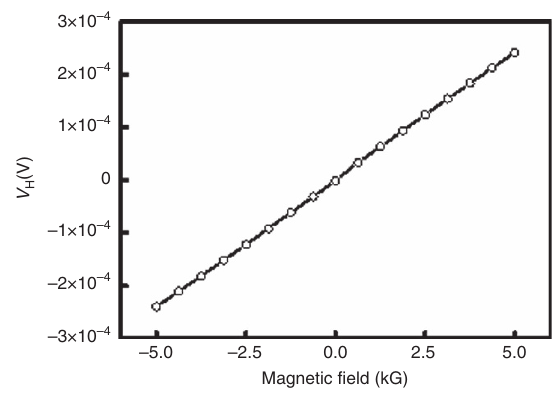
Figure 9 | Hall voltage measured for calibrating the magnet-less Hall devices. The GaN-based device of Fig. 4 was measured, with the Hall voltage shown as a function of applied magnetic field, measured for a device coated with NH 2 -{Ala-Aib} 8 -COCHNH 2 CH 2 PO 4 H 2